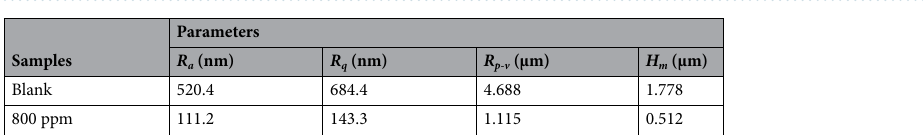
Figure 9. AFM micrograph of MS surface in 1 M HCl without ( a ) and with 800 ppm FV extract ( b ) after 6 h of immersion.